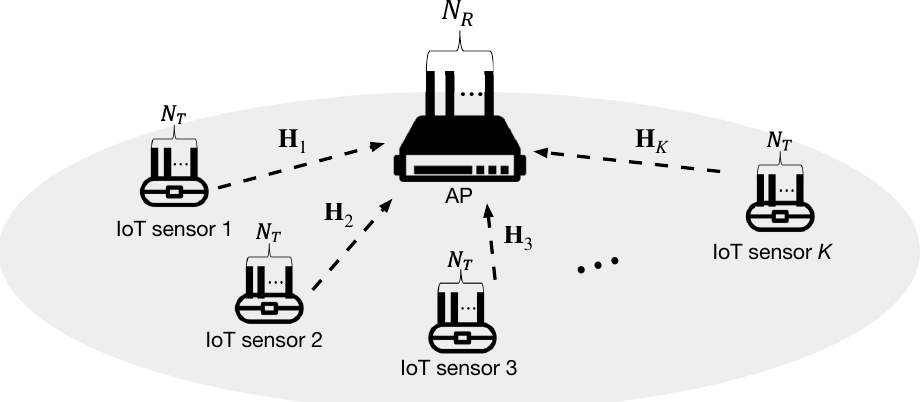
Figure 1. System model of the uplink multiple-input multiple-output (MIMO) wireless internet-of-things (IoT) sensor